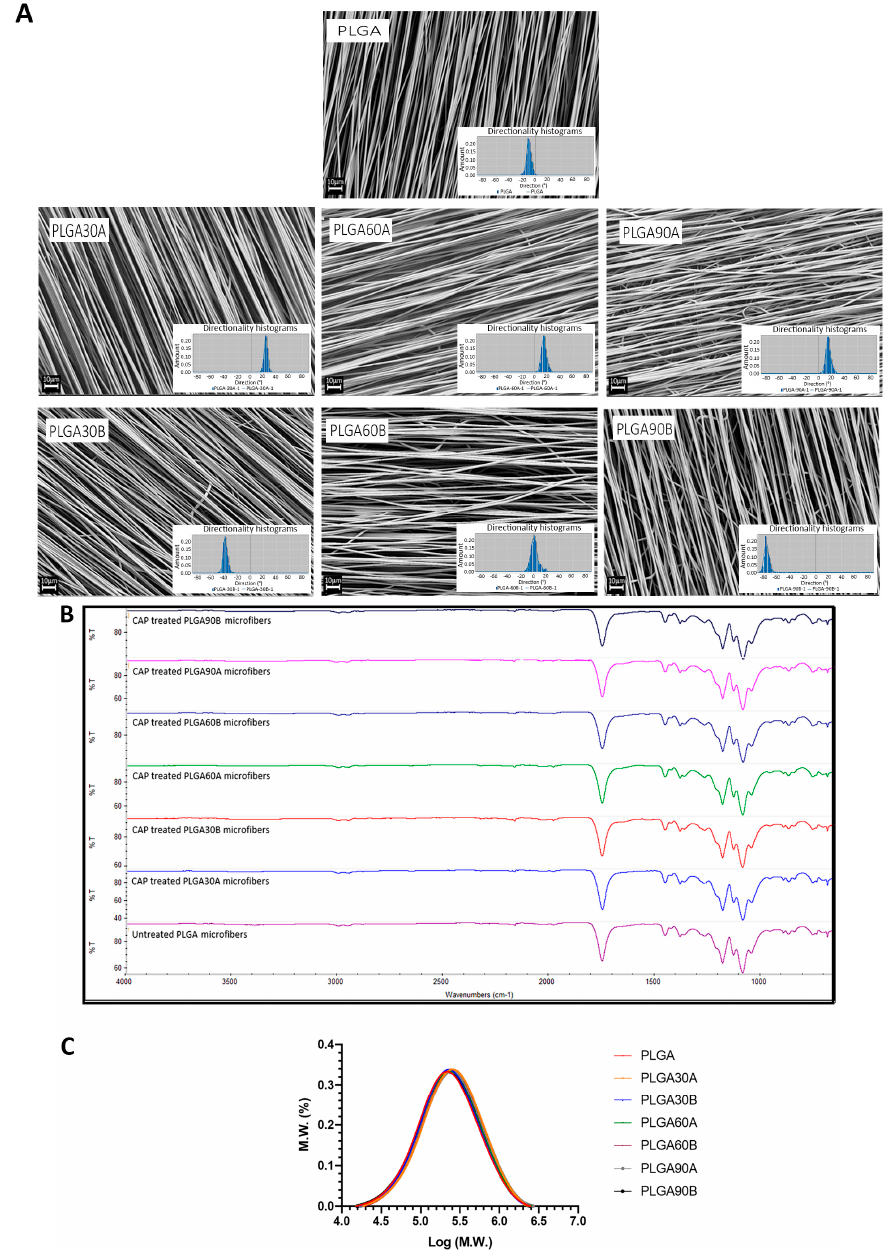
Figure 2. ( A ) SEM investigations of the untreated and plasma-treated electrospun microfibers and the distribution of the fiber orientation. The SEM images showed that the CAP treatment did not affect the morphology neither the alignment of the electrospun microfibers ( p > 0.05). The insets represent the histograms of each sample showing the angle distribution of the electrospun fibers on untreated and CAP treated PLGA samples. It can be noticed that fiber alignment after CAP treatment, by varying the plasma process’ parameters (exposure time and working distance), was maintained as the curves obtained from the analyses showed a sharp Gaussian curve confirming the aligned topography of the microfibers. Scale bars = 10 mm. ( B ) Infrared spectra for untreated and CAP treated PLGA microfibers at different exposure times (30, 60, and 90 s) and working distances (1.3 and 1.7 cm) reported in the 650 and 4000 cm − 1 . ( C ) Molar mass distribution of untreated and CAP treated electrospun PLGA microfibers. Table 2. Fiber alignment of the untreated and CAP treated PLGA microfibers represented by direction, dispersion and goodness.